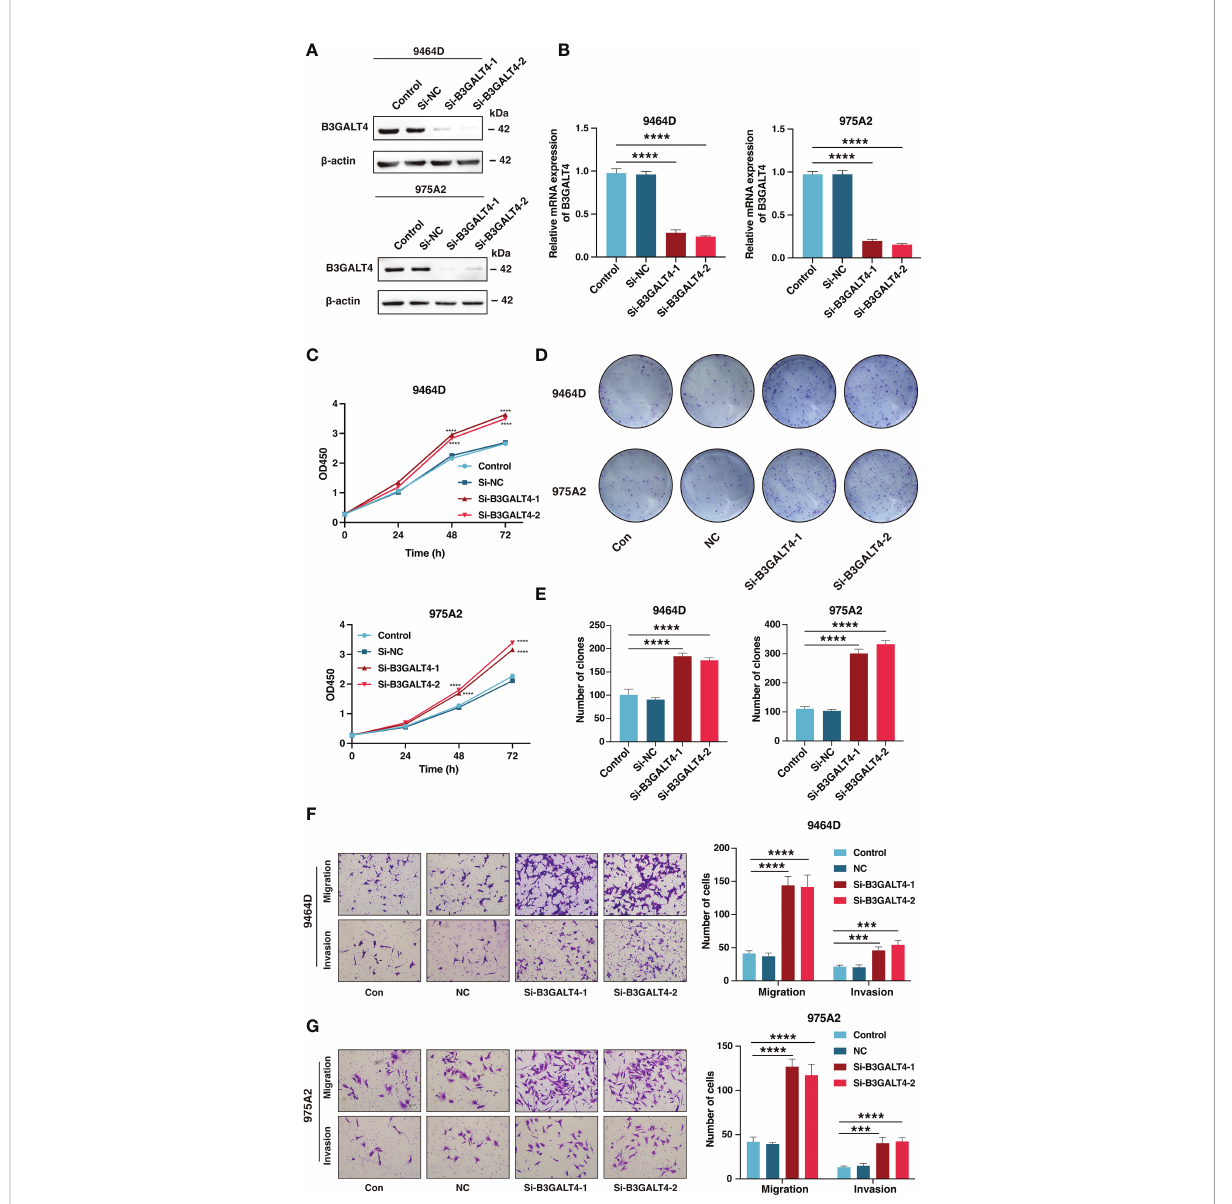
FIGURE 13 The downregulation of B3GALT4 could promote the progression of neuroblastoma. (A, B) The western blot analysis (A) and quantitative real- time PCR (B) was performed to validate the downregulation of B3GALT4 after transfection with siRNA in 9464D and 975A2 cells. (C) The CCK-8 assay was performed to measure the proliferation capacity of 9464D and 975A2 cells. (D, E) The colony formation assay (D) and corresponding statistical analysis (E) of 9464D and 975A2 cells. (F, G) The transwell assays were conducted to determine the effect of down-regulated B3GALT4 on neuroblastoma migration and invasion capacity in 9464D (F) and 975A2 cells (G) . (***, P< 0.001; ****, P<